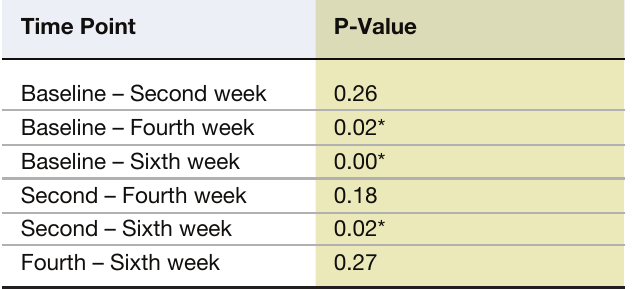
Table 7. Post Hoc Test (Least Square Difference) of Physical Function Scores of Participants in the Tele-physiotherapy Group across Baseline, Second, Fourth and Sixth Week of Intervention